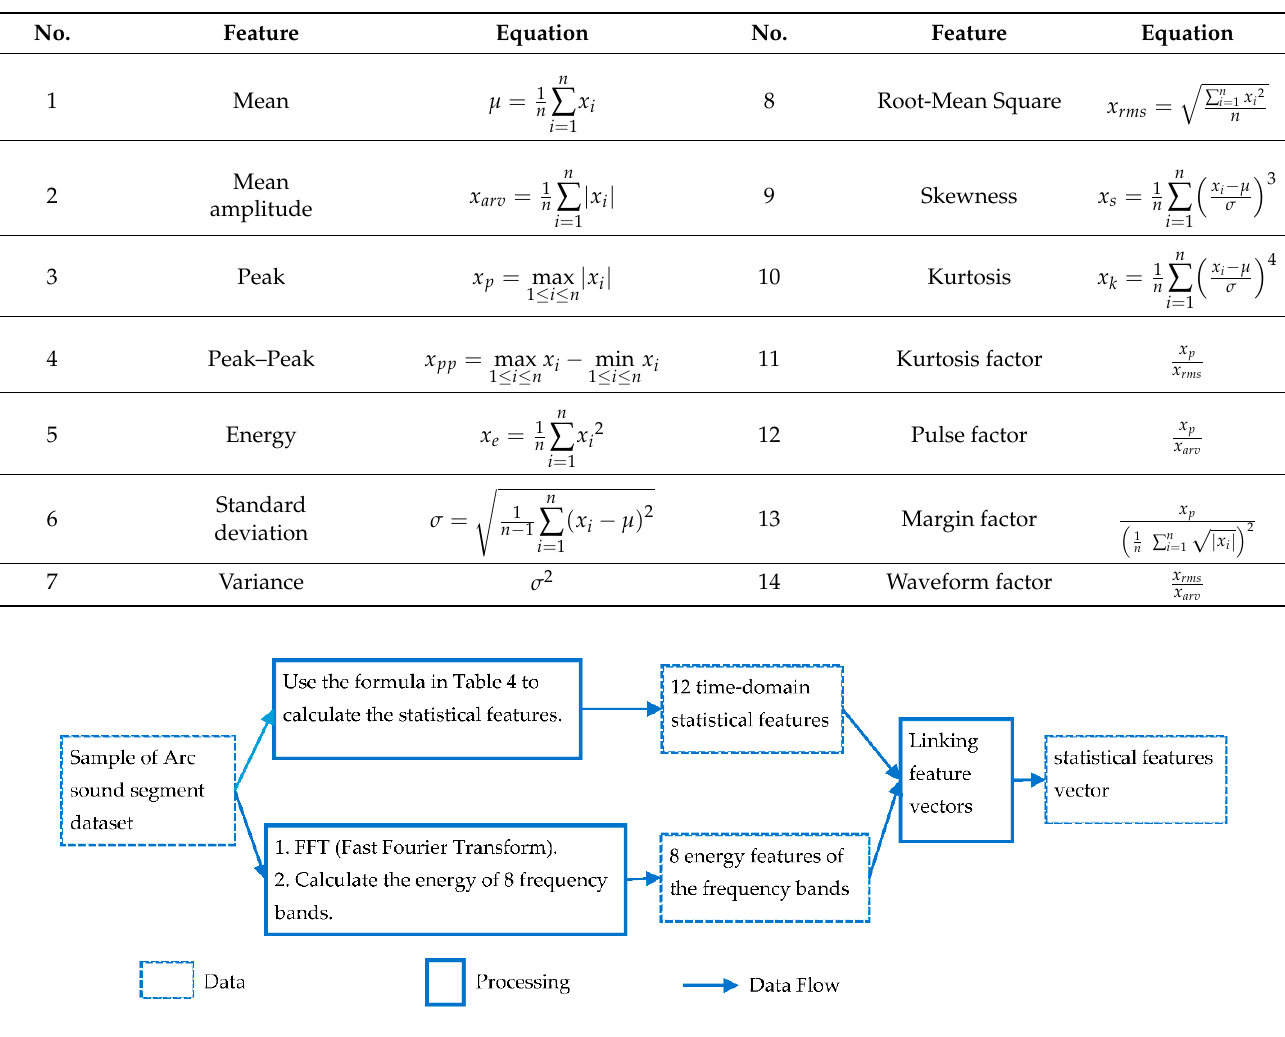
Table 4. Time domain statistical features equations.